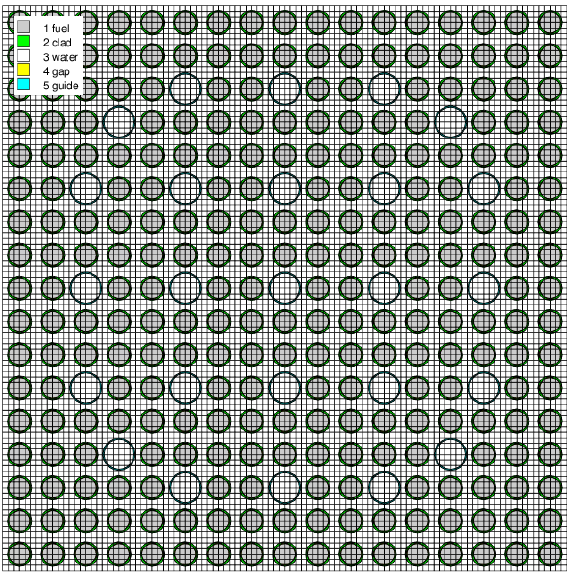
Figure 1. Fuel assembly depletion model in